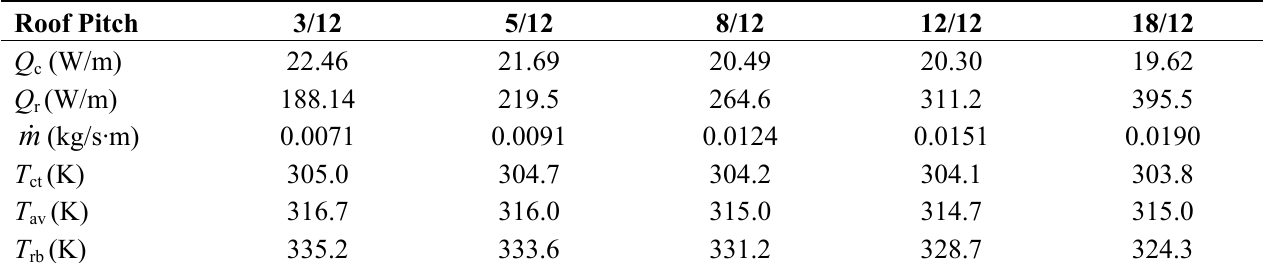
Table 4. Summary of numerical results for R-10 cases.